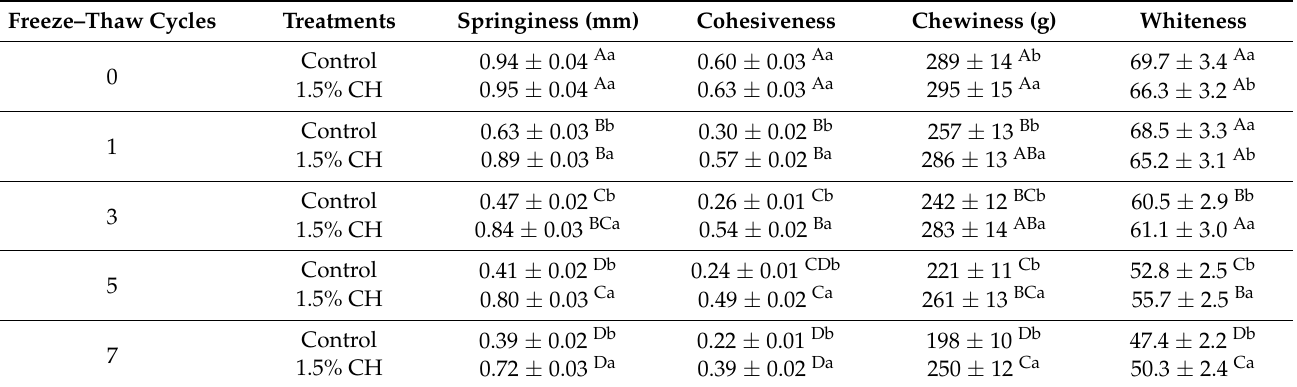
Table 3. Influence of chitosan ice coating on the texture properties and whiteness of fish balls induced by freeze–thaw